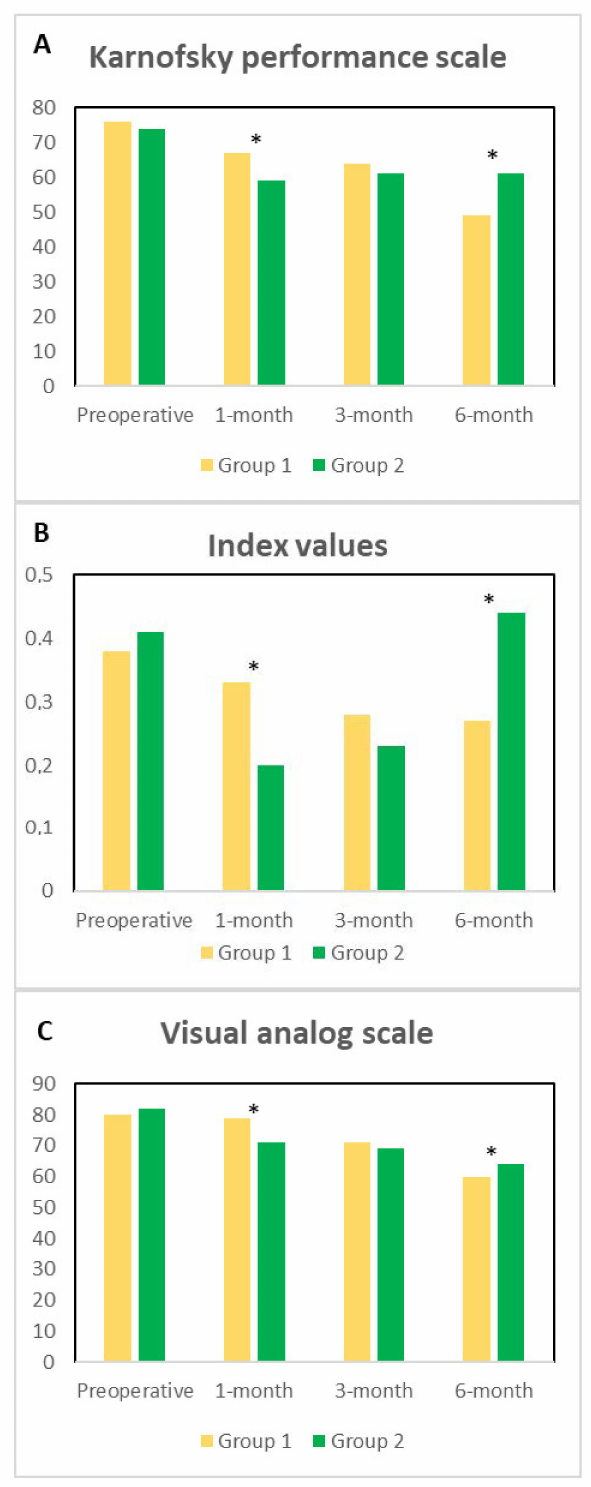
Figure 1. Panel ( A ). Preoperative, at 1-, 3- and 6-month Karnofsky performance scale among the groups of patients is described. Panel ( B ). Preoperative, at 1-, 3- and 6-month Index values among the groups of patients is described. Panel ( C ). Preoperative, at 1-, 3- and 6-month Visual analog scale among the groups of patients is described. The significances among the groups are depicted with